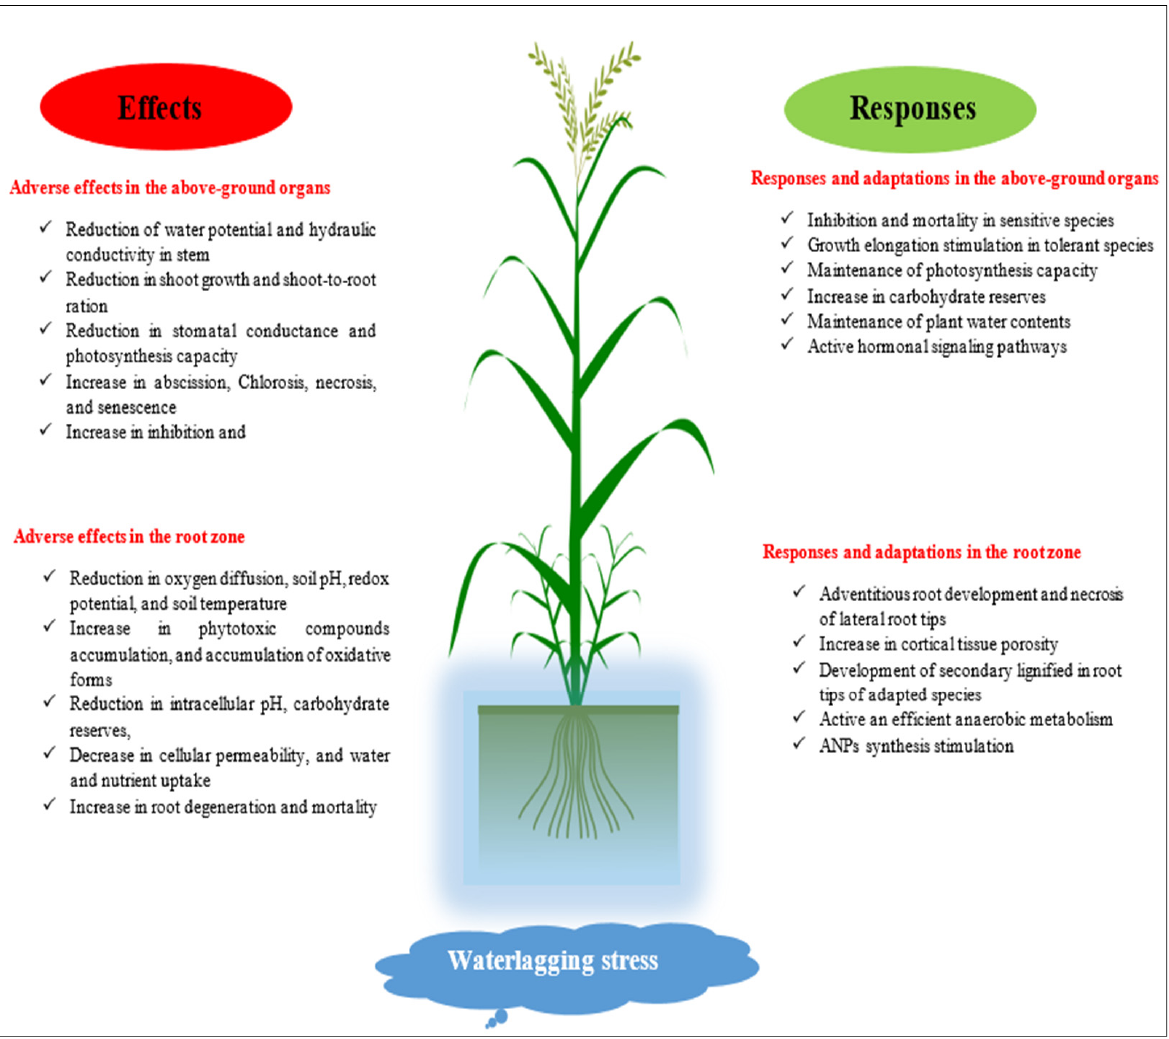
Figure 5. Important effects of waterlogging stress, and plants’ responses to it.